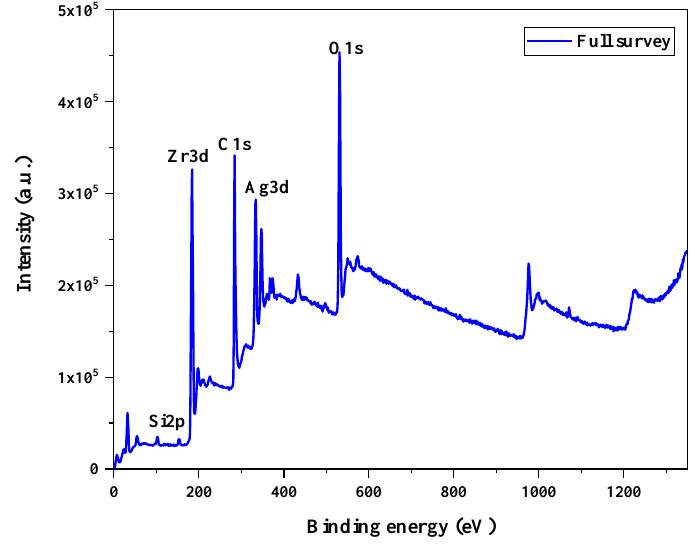
Figure 5. XPS spectra of ZrO 2 -Ag-G-SiO 2 survey.